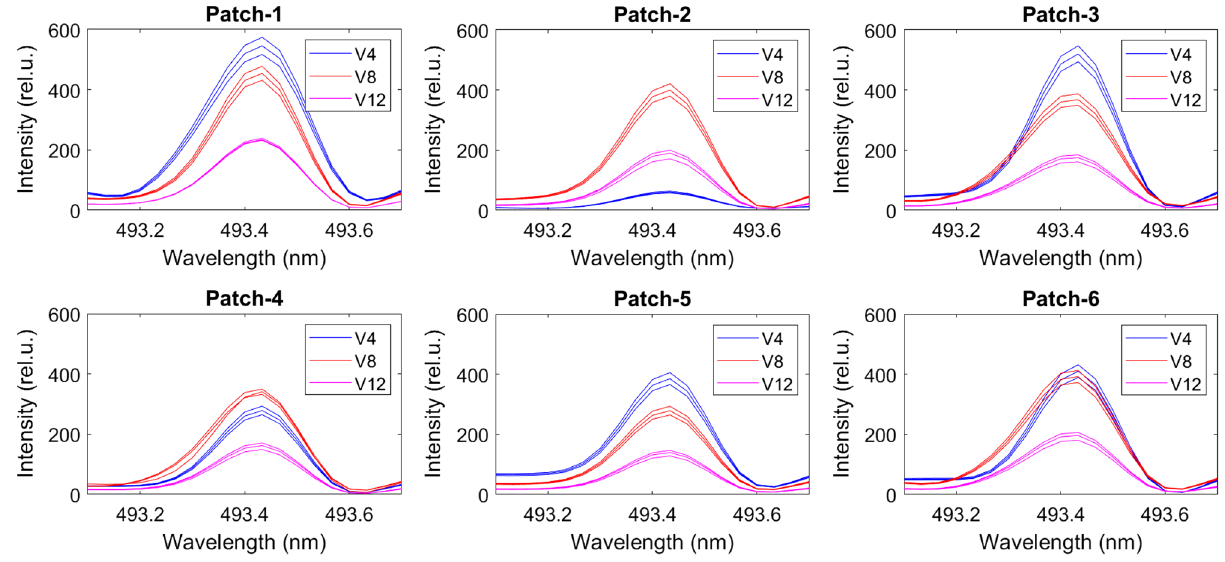
Figure 5. Nitrogen spectrum of the soil samples at 493.4 nm for six patches at the V4, V8 and V12 stages.